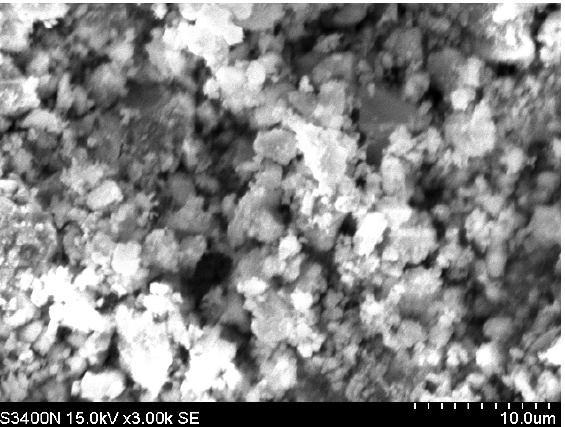
Figure 18. SEM image of the microstructures 20 mm below the inner coating of the substrate when W/C = 0.4 (3000×; 4C2, 56 days).